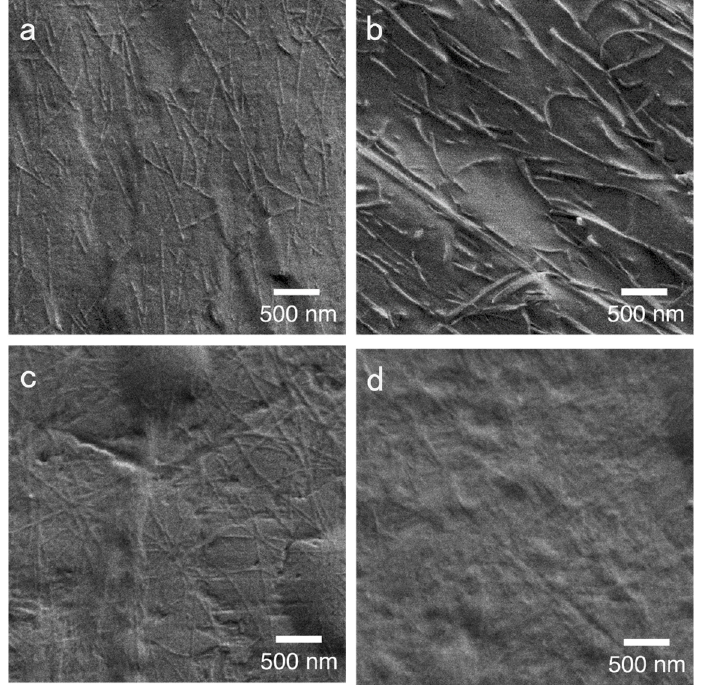
Figure 3. Cryo-SEM images of the surfactant aqueous solutions. Typical images of ( a ) 9-2-2-6 solu- tion quickly frozen from room temperature (< T gel ), ( b ) 11-2-2-6 solution quickly frozen from room temperature (< T gel ), ( c ) 9-2-2-6 solution quickly frozen from about 60 °C (> T gel ), and ( d ) 11-2-2-6 so- lution quickly frozen from about 80 °C (> T gel ).